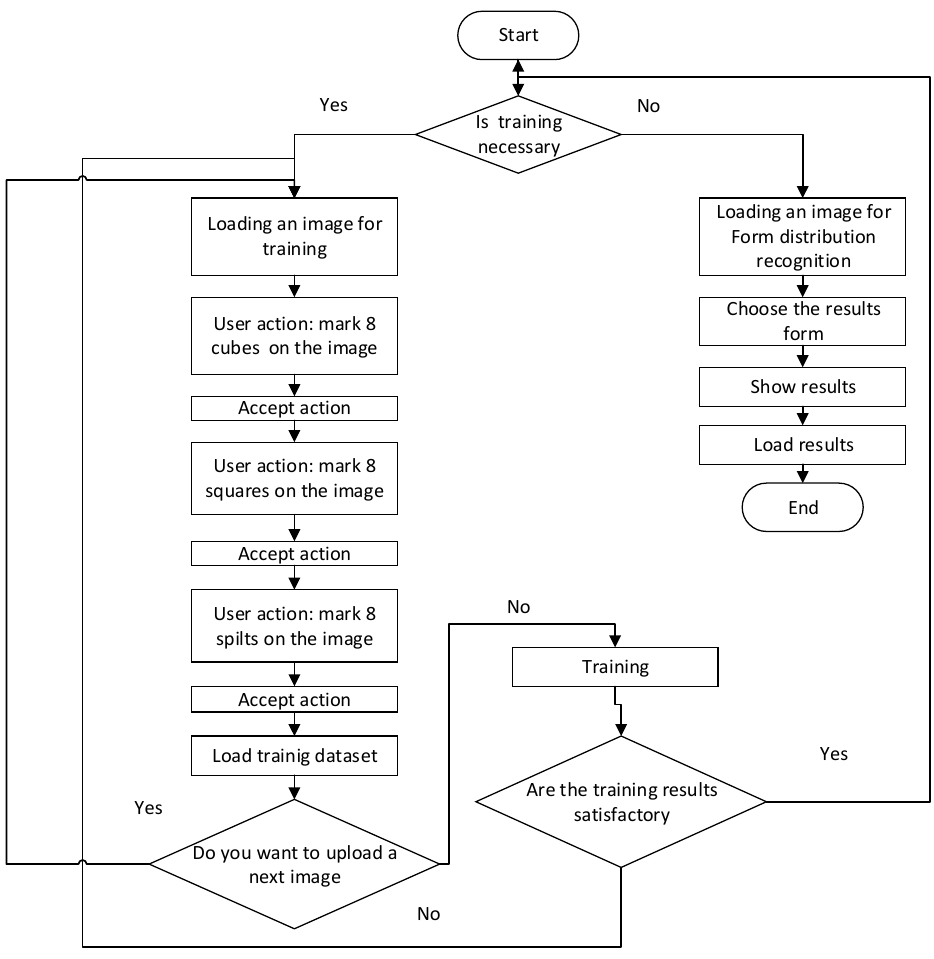
Figure 3. Algorithm of the system for recognizing the distribution of lumps of rock mass by their fragment form.